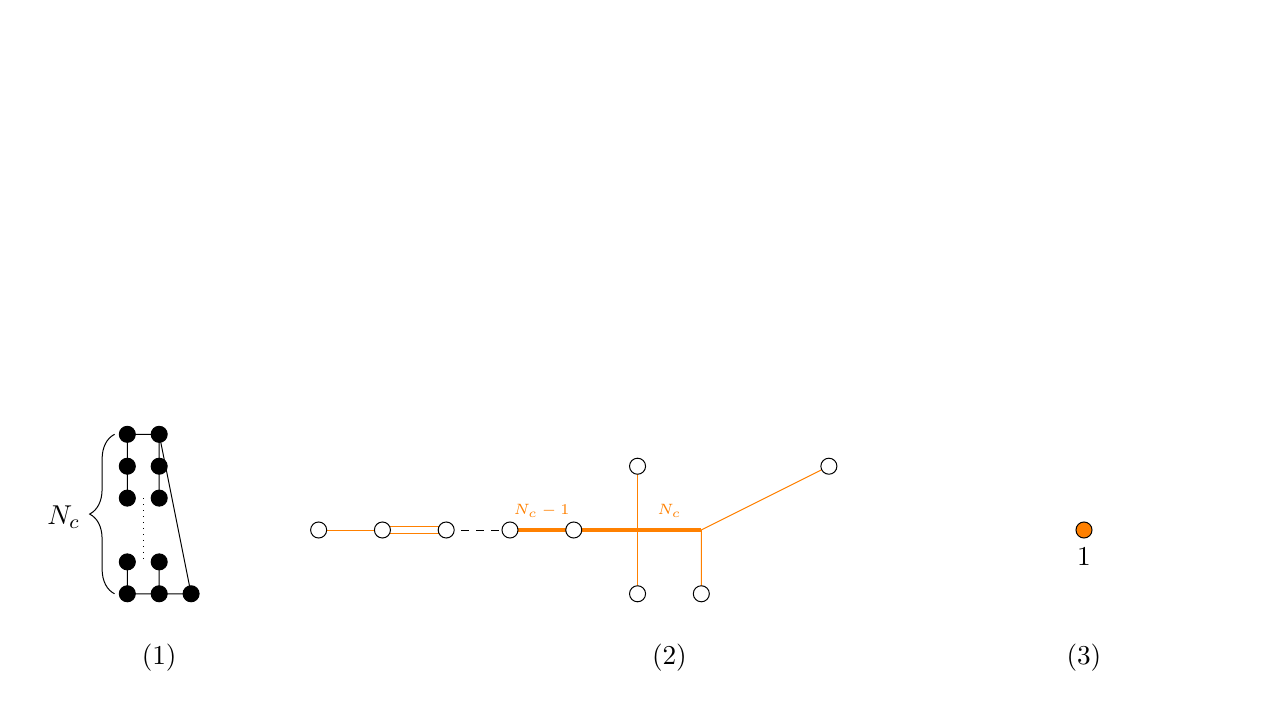
Figure 11 . (1) Toric Diagram representing SQCD with N f = N c at finite gauge coupling where masses are set to zero. (2) Brane Web indicating the intersection of the baryonic branch and the mesonic branch of the Higgs Branch (3) magnetic Quiver whose 3d Coulomb Branch is the intersection of the baryonic branch and the mesonic branch of the Higgs Branch of our